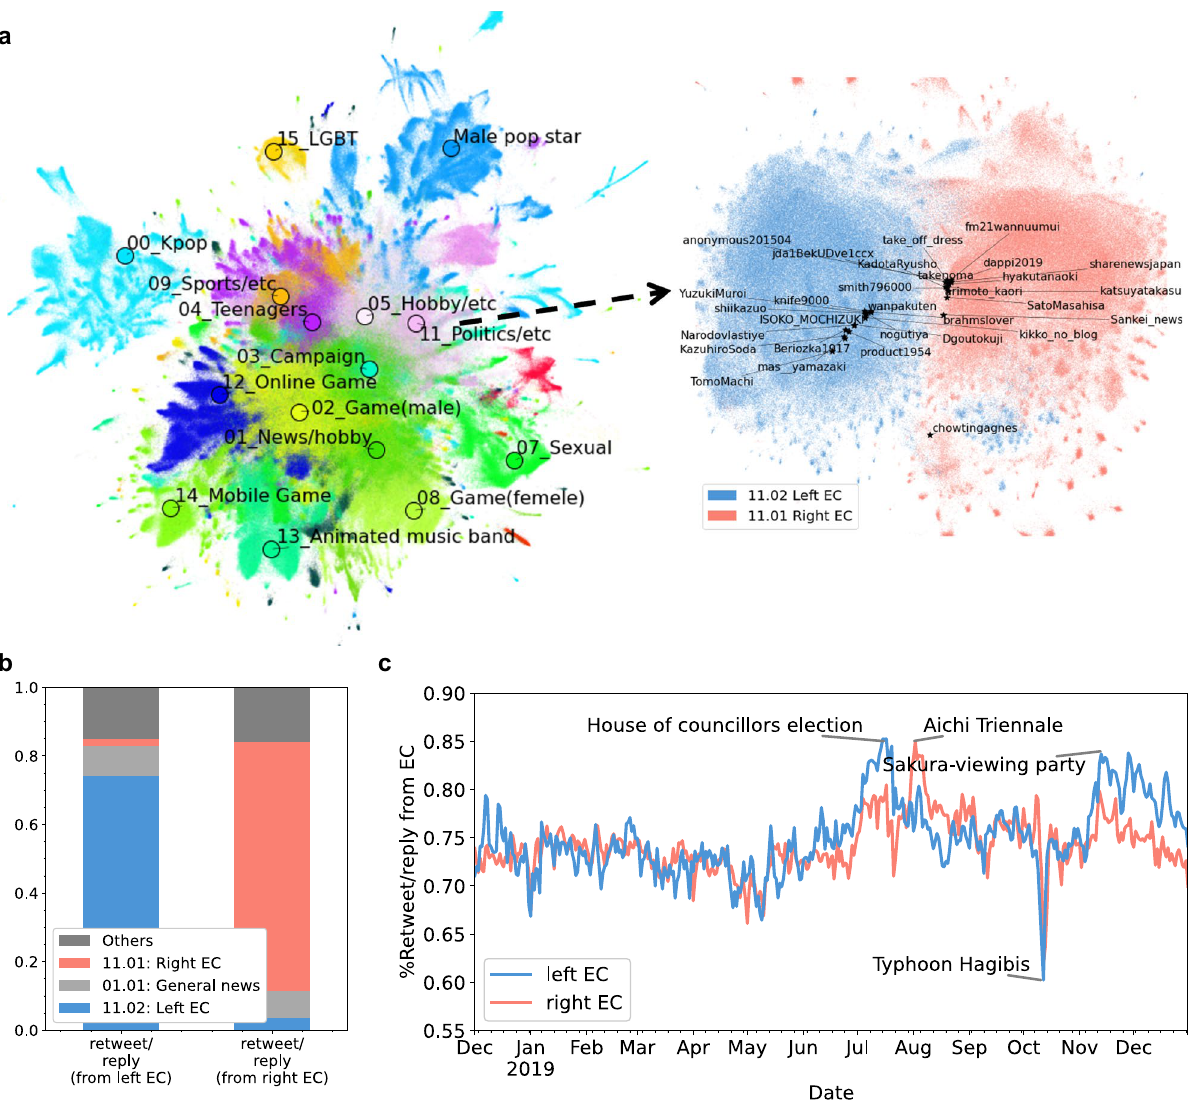
Figure 1. ( a ) left Visualisation of 42 million Japanese Twitter users. Each dot corresponds to a user coloured according to his/her cluster. Users are embedded in a 2D space with LINE 50 (network representation learning) and UMAP 51 (dimension reduction). The manually annotated labels of the top 15 clusters based on the number of users are plotted. ( a ), right Visualisation of the left- and right-leaning political ECs: The users in subcluster 11.02 (left EC) are coloured blue, and those in 11.01 (right EC) are coloured red. The top 20 influencers of each subcluster are plotted with their user names. ( b ) Ratio of clusters containing the origins of retweets/replies from the left- and right-leaning ECs. c Daily internal information ratio (the ratio of the origins of retweets/replies made by users of the EC in the same cluster).